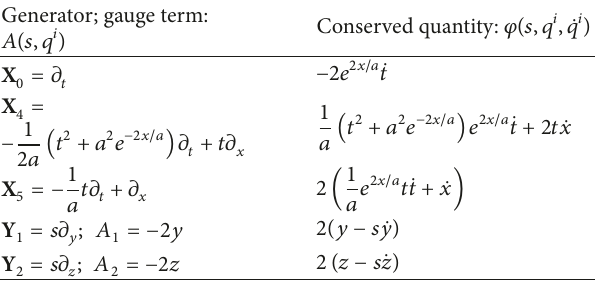
Table 6: Conserved quantities corresponding to each Noether symmetry.